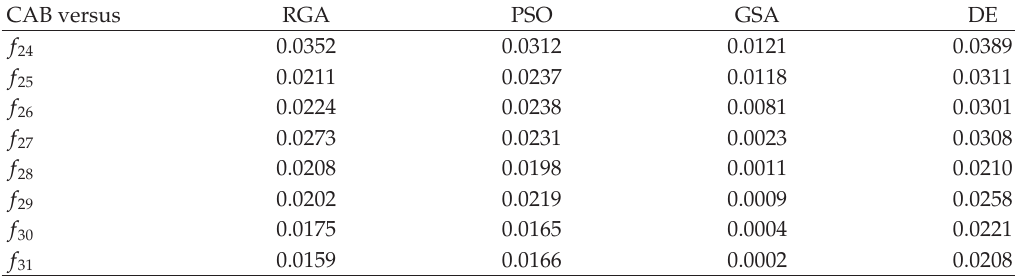
Table 9: P values produced by Wilcoxon’s test comparing CAB versus RGA, PSO, GSA, and DE over the “average best-so-far” values from Table